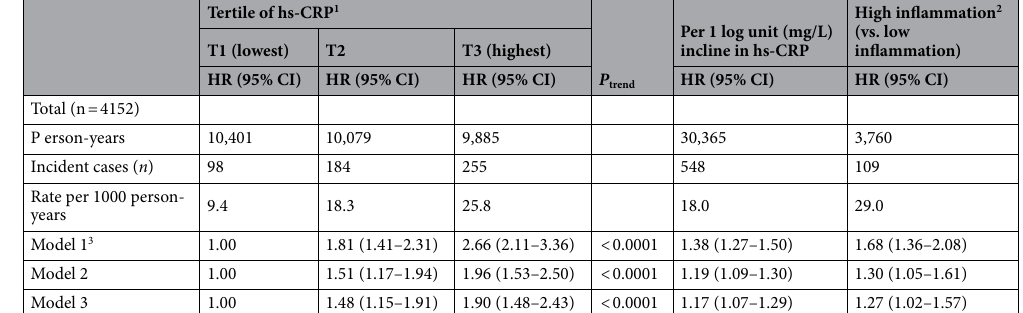
Table 3. Adjusted hazard ratios (with 95% confidence intervals) for type 2 diabetes according to high- sensitivity C-reactive protein levels in Korean adults aged 45–76 years. T tertile; hs-CRP high-sensitivity C-reactive protein; HR hazard ratio; CI confidence interval. 1 Cut-offs for tertiles 1–3 of hs-CRP levels are as follows: < 0.45, 0.45–1.04, and > 1.04 mg/L in men and < 0.38, 0.38–0.89, and > 0.89 mg/L in women, respectively. 2 High inflammation is defined as > 2 mg/L of hs-CRP levels. 3 Model 1: adjusted for sex (men or women) and age (years); Model 2: additionally adjusted for area of residence (Ansan or Ansung), education level (≤ elementary school, middle/high school, or ≥ college), smoking status (never, past, or current), alcohol consumption (g/d), regular physical activity (yes or no), body mass index (kg/m 2 ), waist circumference (cm), systolic and diastolic blood pressure (mmHg), triglyceride (mg/dL), total cholesterol (mg/dL), high-density lipoprotein cholesterol (mg/dL) and fasting blood glucose level (mg/dL), and family history of diabetes (yes or no); Model 3: additionally adjusted for log-transformed serum uric acid levels.